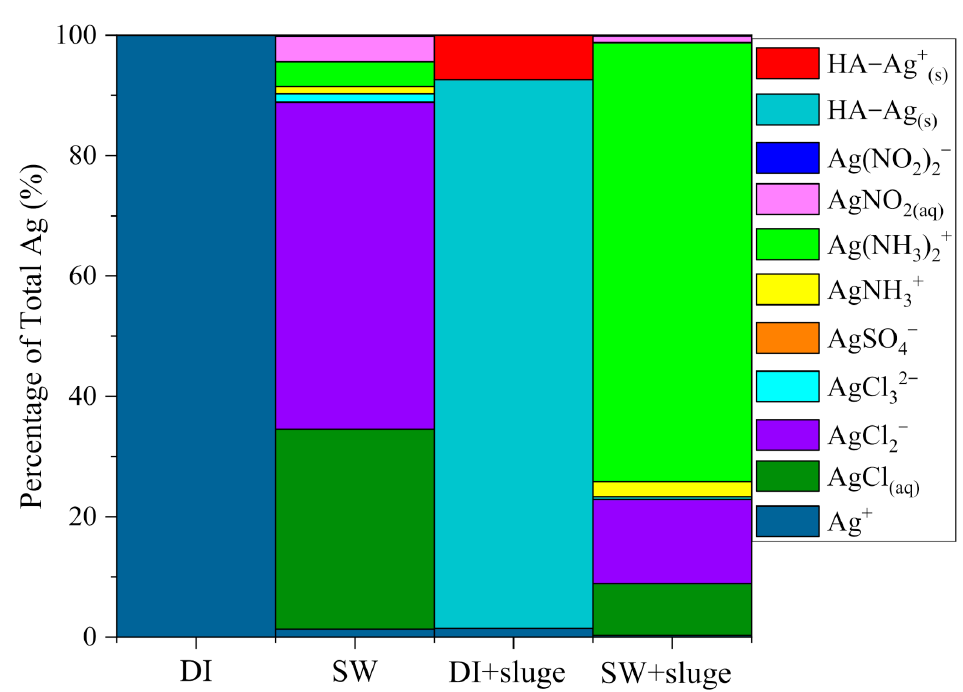
Figure 8. The calculated theoretical equilibrium speciation for dissolved Ag after exposing cit − AgNPs (50 × dilution, 1.7 × 10 10 particles mL − 1 , 1.68 mg L − 1 ) in DI and SW, with or without sludge, respectively, using visual MINTEQ, version 3.1. Notes: pH and IS in SW was 8.7 and 100 mM respectively. HA in sludge was 42 mg L − 1